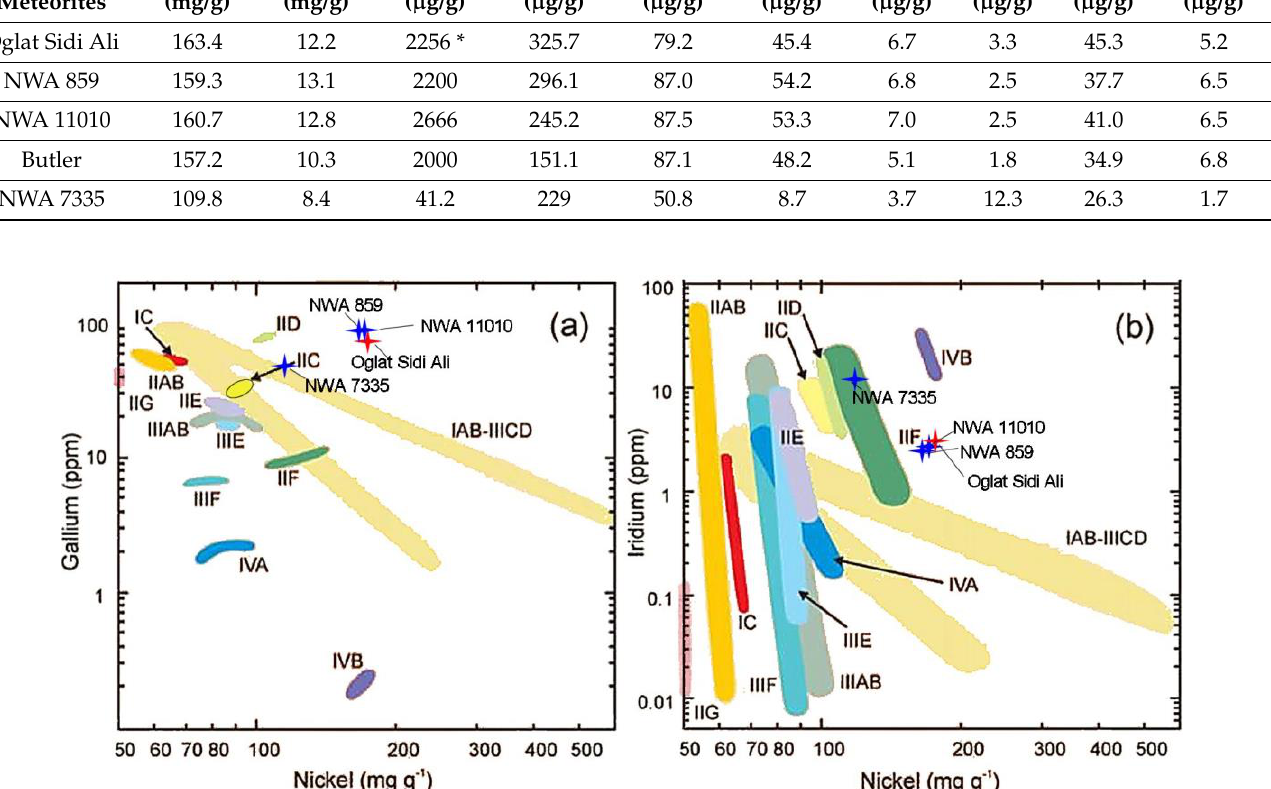
Figure 10. Logarithmic plot of the bulk amounts of Ga ( a ) and Ir ( µ g/g) ( b ) versus Ni (mg/g) of the Oglat Sidi Ali meteorite and some NWA ungrouped irons and literature data for various iron meteorite groups (modified based on Grady et al.